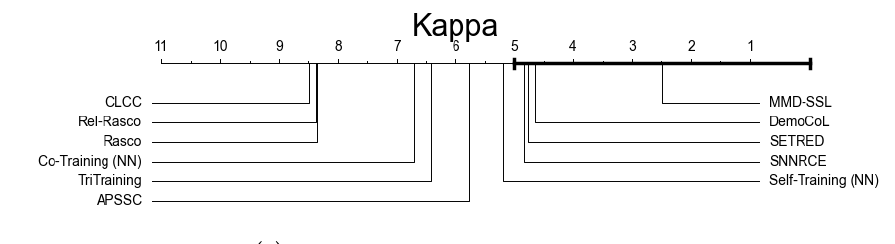
Figure 4. Critical difference diagrams corresponding to accuracy comparisons in Tables 3 and 4.